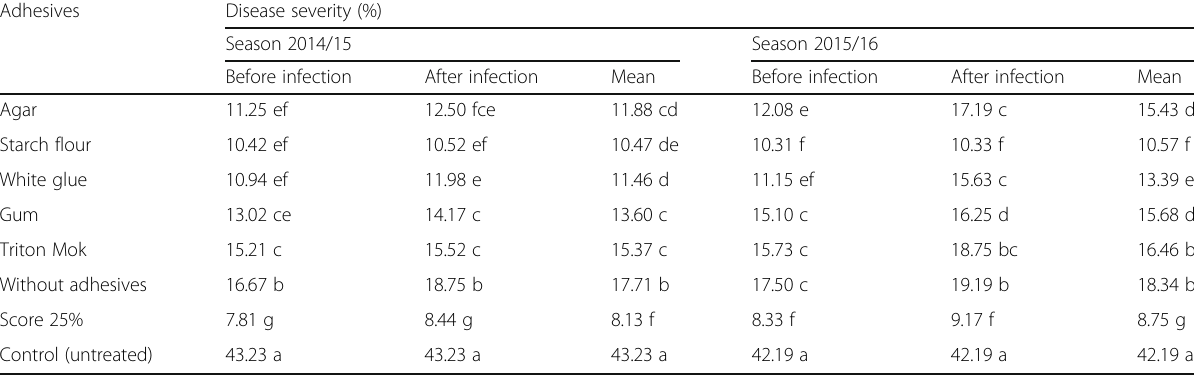
Table 2 Effect of foliar treatment with spore suspension of Penicillium frequentans on Cercospora leaf spot of sugar beet under field conditions during 2014/15 and 2015/16 growing